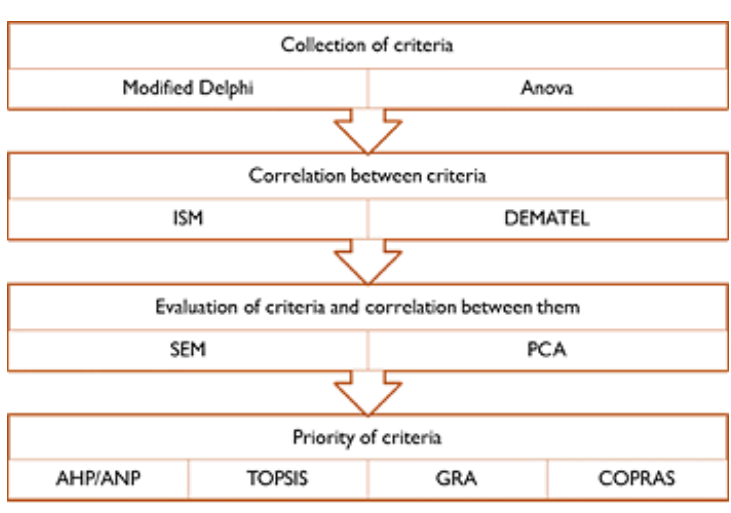
Figure 10. Direction guide of criteria